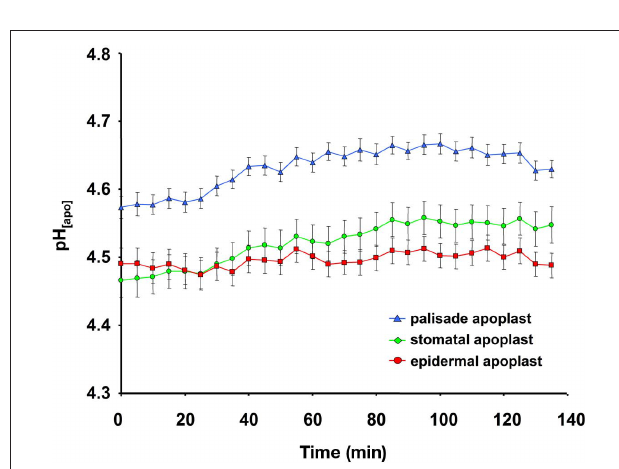
Figure 7 | Dependency of the Oregon green 488 F Ratios are displayed against NaCl concentration. NaCl ranging from 0 to 125 mM was mixed into the dye solution (25 μM Oregon Green). Ratios were stable and thus not affected by NaCl. Values represent the mean ± SE ( n = 4 biological replicates). t -Test revealed no significant mean differences at p ≤ 0.05.